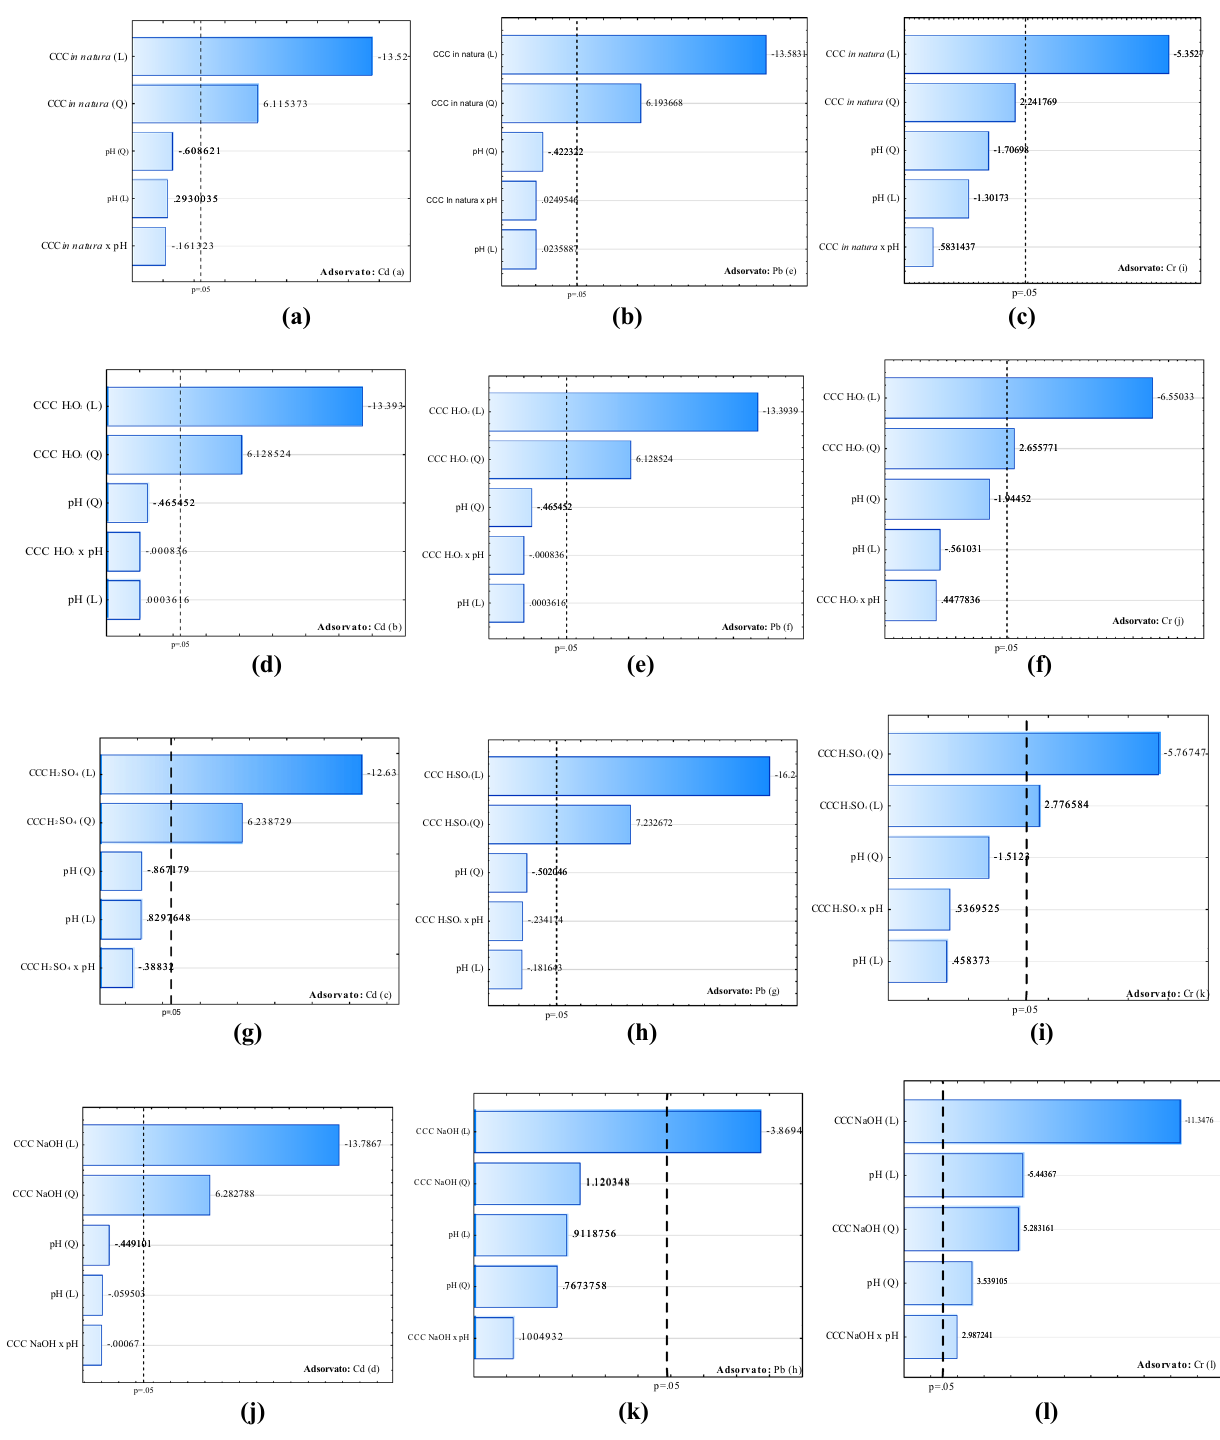
Fig. 6 Pareto graph from CCRD analysis for the adsorbent masses and solution pH on sorption of Cd 2+ ( a – d ), Pb 2+ ( e – h ) and Cr 3+ ( i – l ) on cashew nut shell (CNS) in natura , modified with H 2 O 2 , H 2 SO 4 and